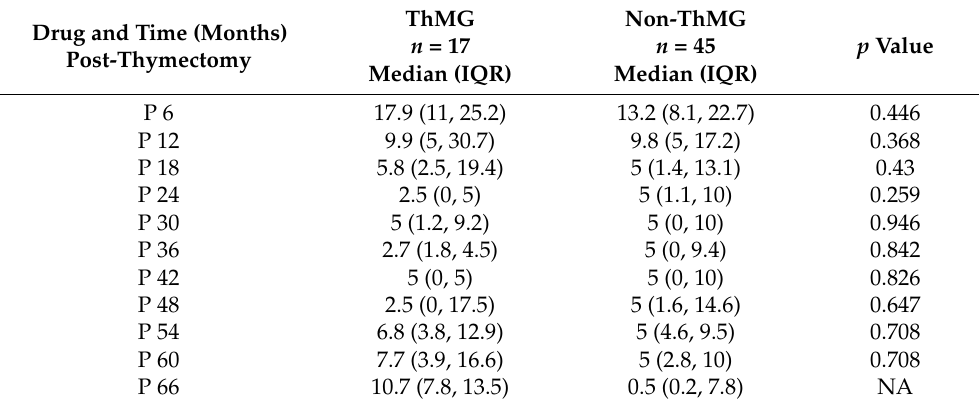
Table 4. Comparison of time-weighted averages (TWAs) of prednisolone (p) dosage requirements (mg/d) after thymectomy between ThMG and non-ThMG patients. Drug and Time (Months)